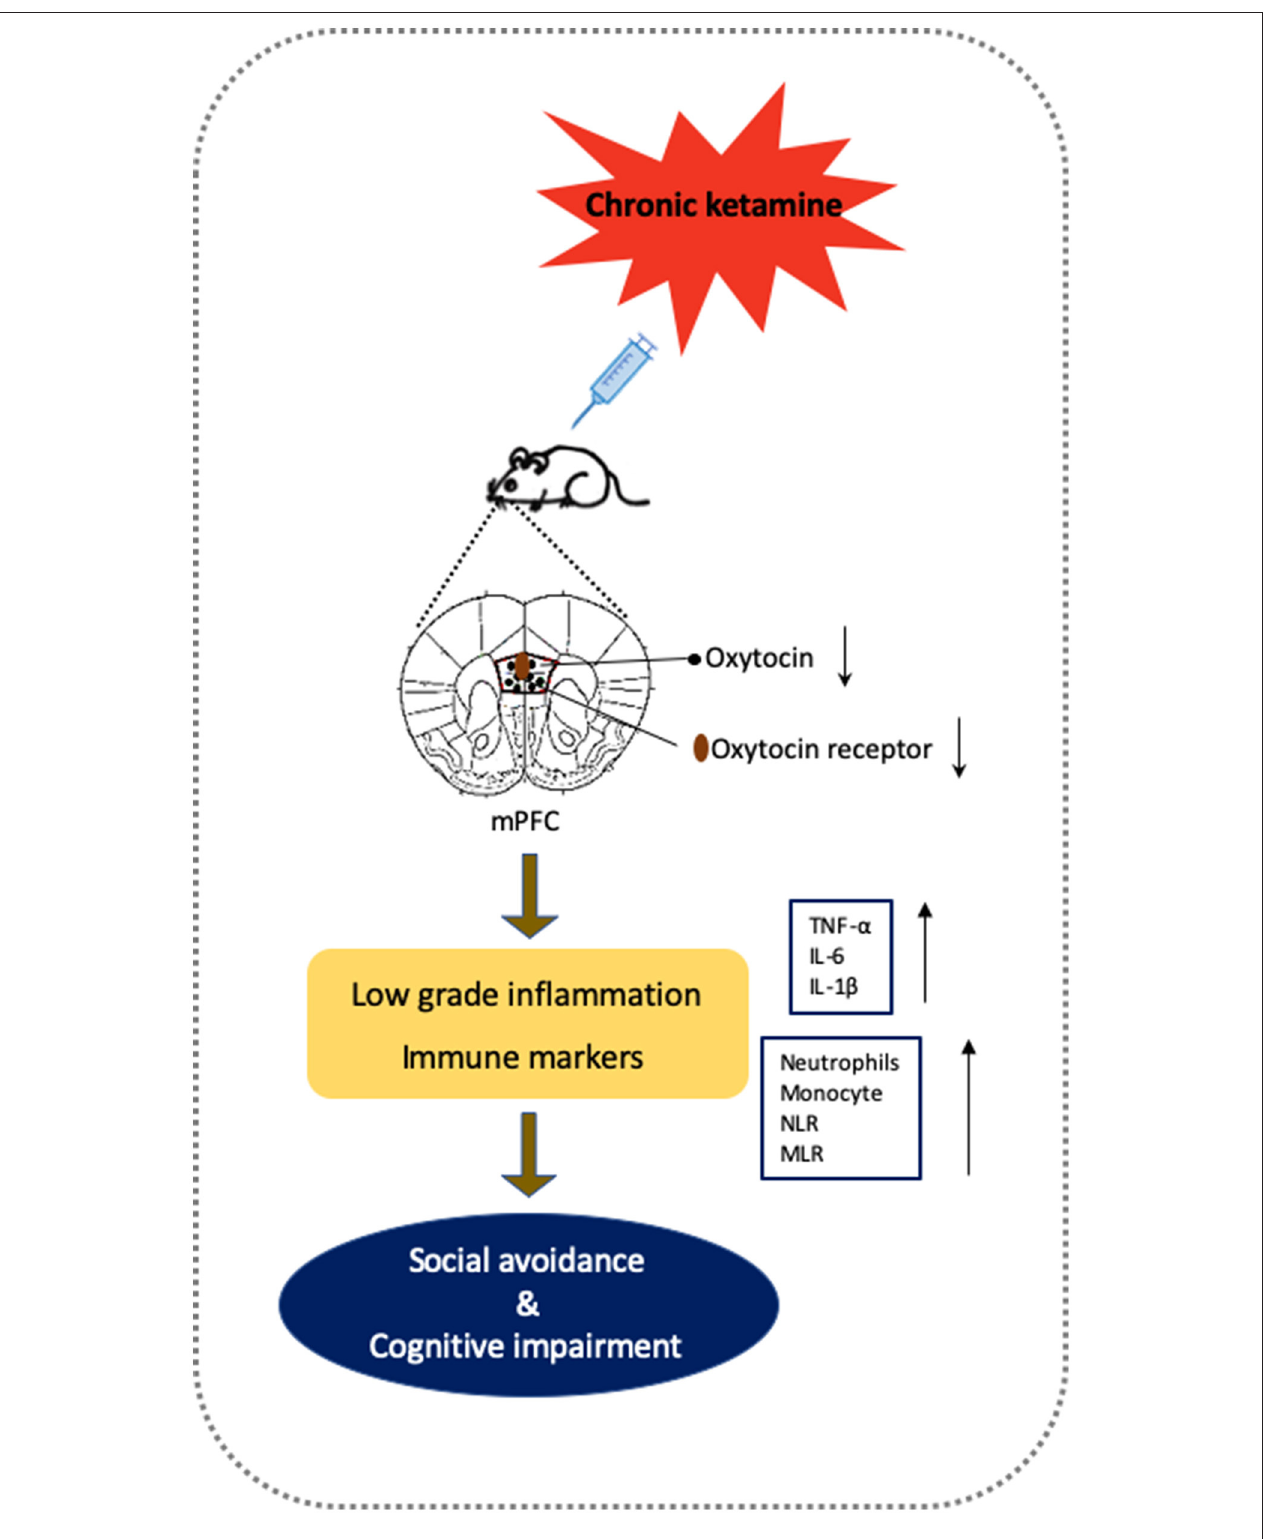
FIGURE 7 | Putative framework of oxytocin on the social avoidance and cognitive dysfunctions induced by chronic ketamine exposure and withdrawal according to experimental findings. Chronic ketamine exposure decreases oxytocin activity, which impairs mPFC function. Chronic mPFC dysfunction in vulnerable animals increases low-grade inflammation (shown by elevated inflammatory cytokines TNF- α , IL-6 < , and IL-1 β ) and altered immune markers (increased neutrophils, monocyte, NLR, and MLR), producing social avoidance and cognitive impairment. Supplementary oxytocin protects mPFC and inflammatory processes from damage by ketamine to reverse behavioral